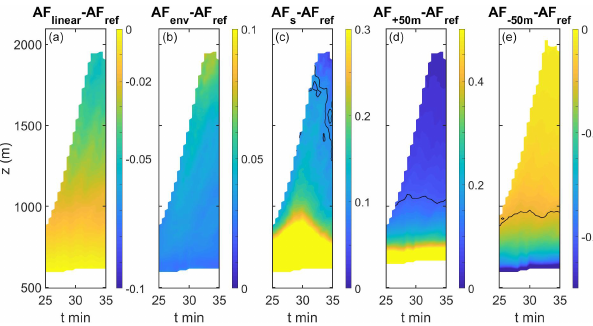
Figure 7. Mean differences in AFs vs. time and height for a clean